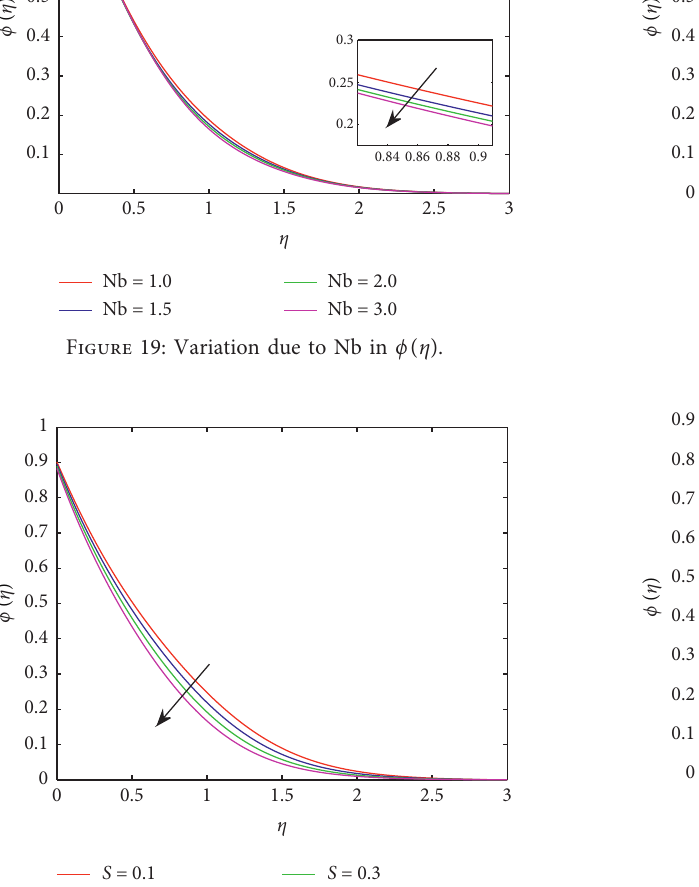
Figure 20: Variation due to S in ϕ ( η ) .